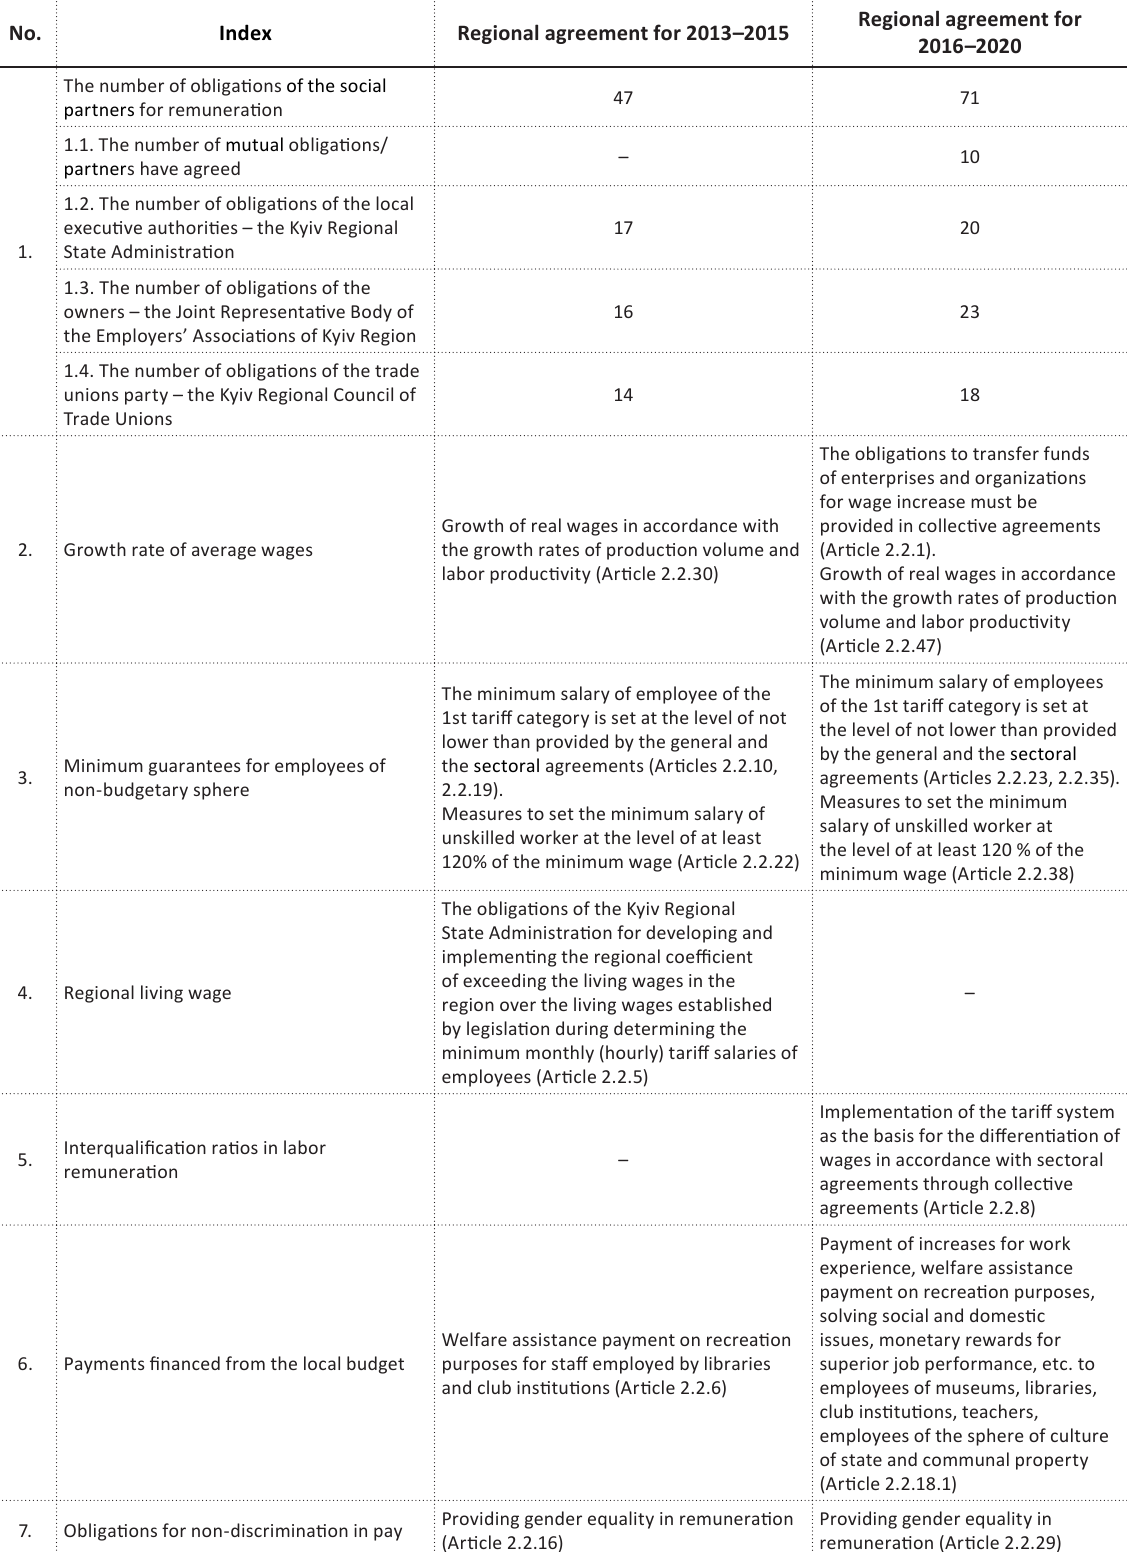
Table 3. The number of obligations of the social partners for remuneration according to the